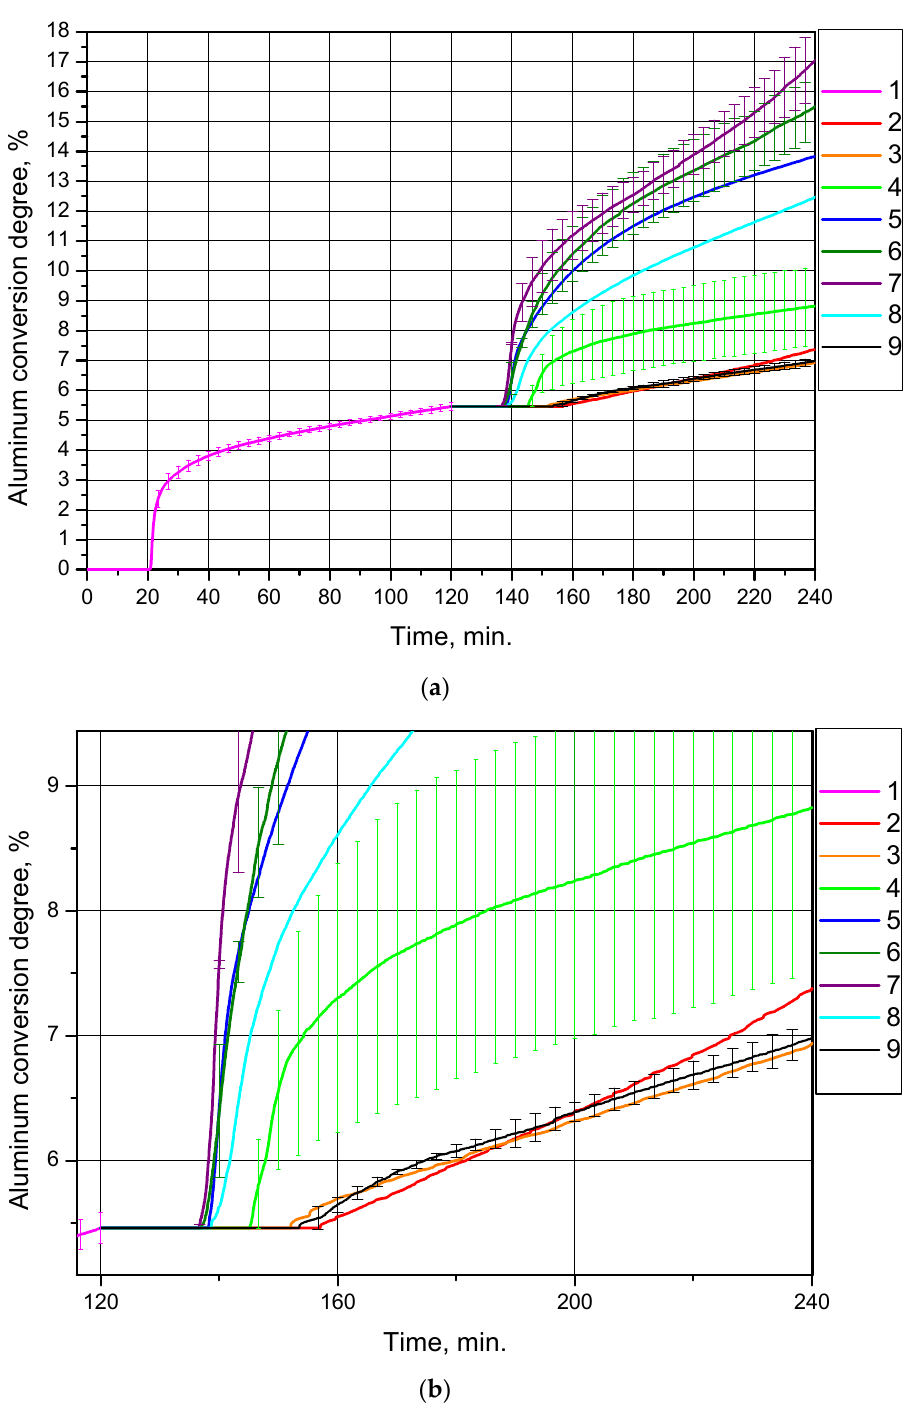
Figure 4. Aluminum conversion degrees (hydrogen yields) for different powder samples: ( a ) original size; ( b ) magnified section: 1—original aluminum powder, 2—sample after drying at 120 °C, 3—sample after thermal treatment at 200 °C, 4—sample after thermal treatment at 300 °C, 5—sample after thermal treatment at 450 °C, 6—sample after thermal treatment at 400 °C, 7—sample after thermal treatment at 500 °C, 8—sample after thermal treatment at 550 °C, 9—sample after thermal treatment at 600 °C.